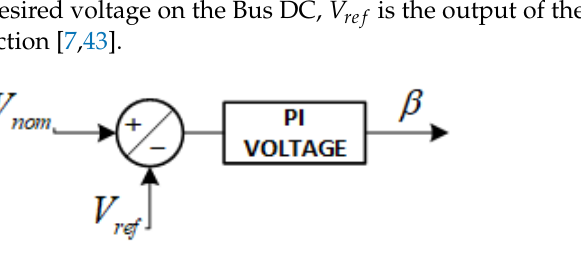
Figure 8. Voltage restorer secondary control strategy.